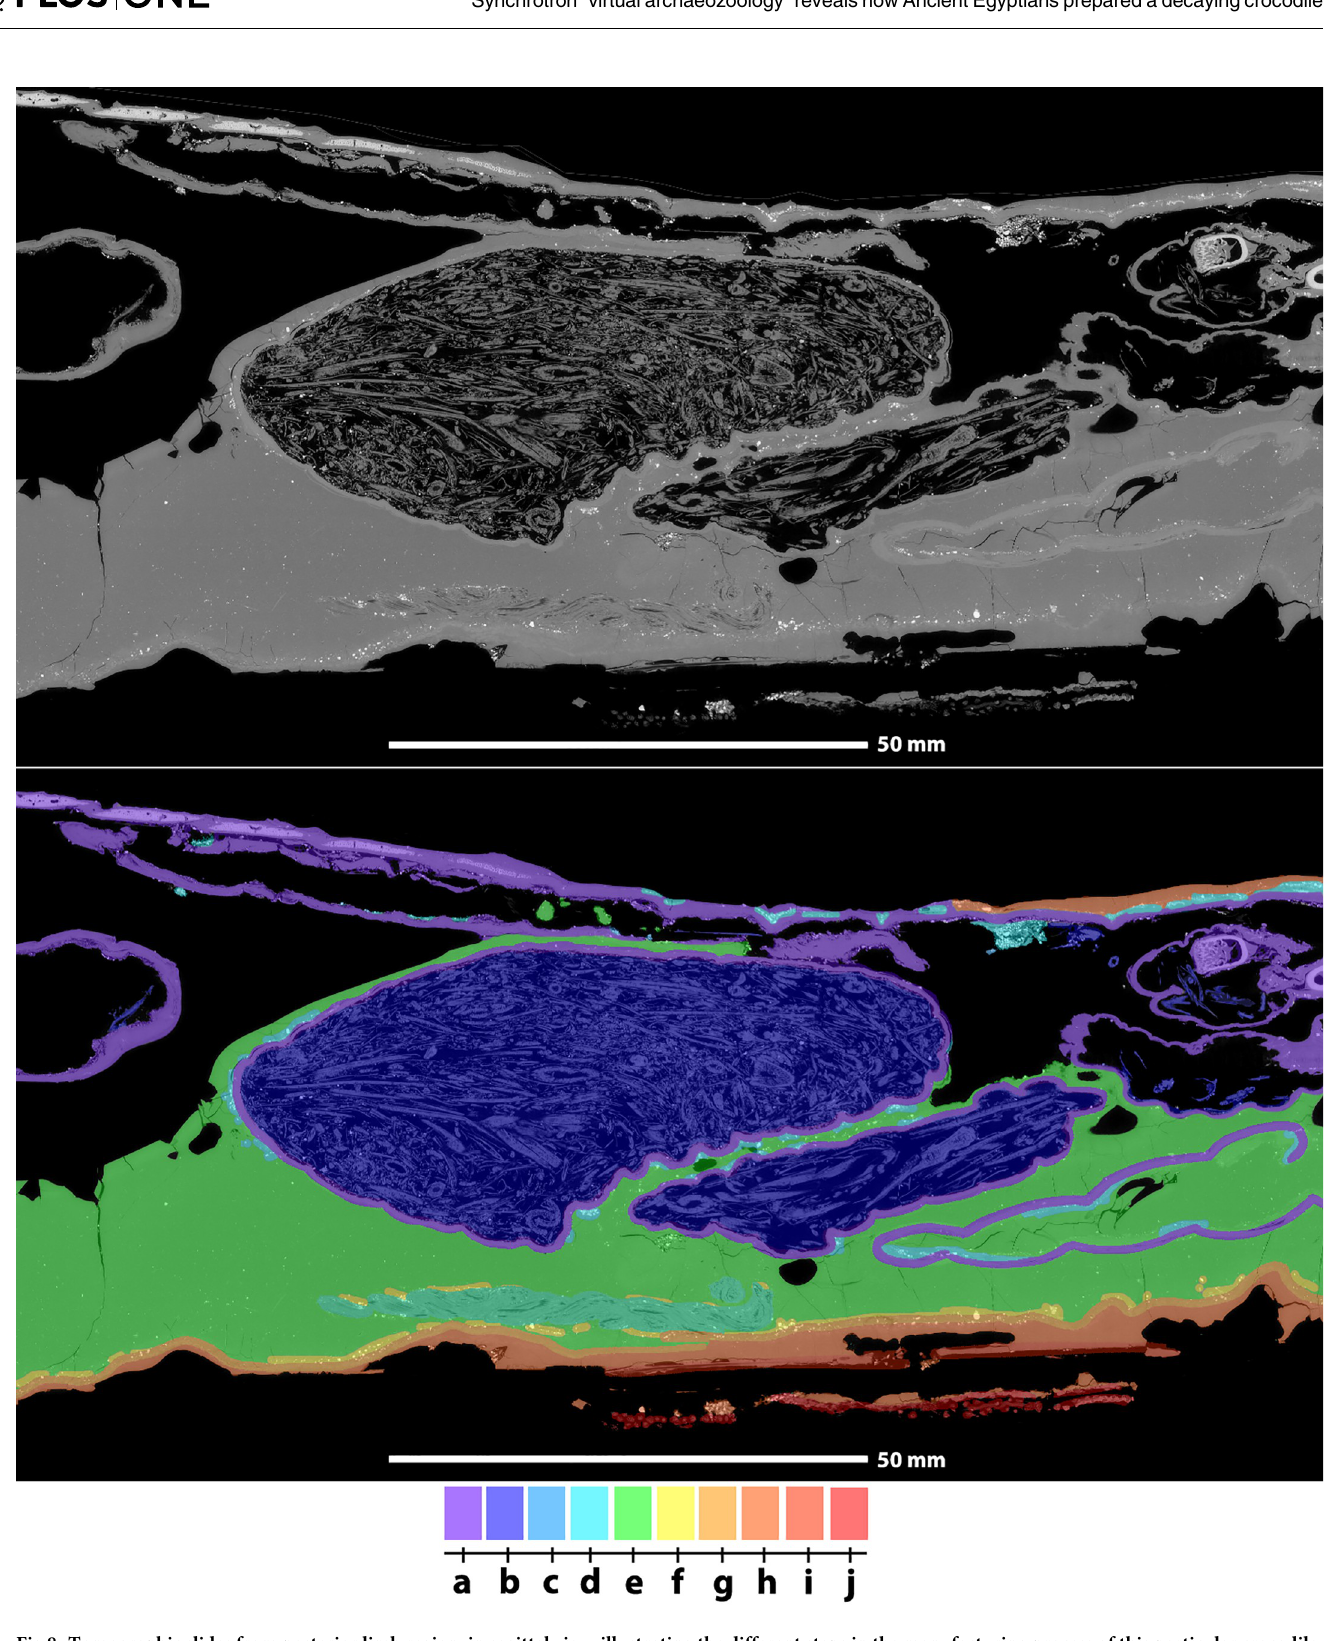
Fig 8. Tomographic slides from posterior limb region, in sagittal view, illustrating the different steps in the manufacturing process of this particular crocodile mummy. The colour gradient corresponds to the successive stages of the manufacturing protocol for this mummy (From a. to j. , see main text for stage description). https://doi.org/10.1371/journal.pone.0229140.g008 PLOS ONE | https://doi.org/10.1371/journal.pone.0229140 February 21,